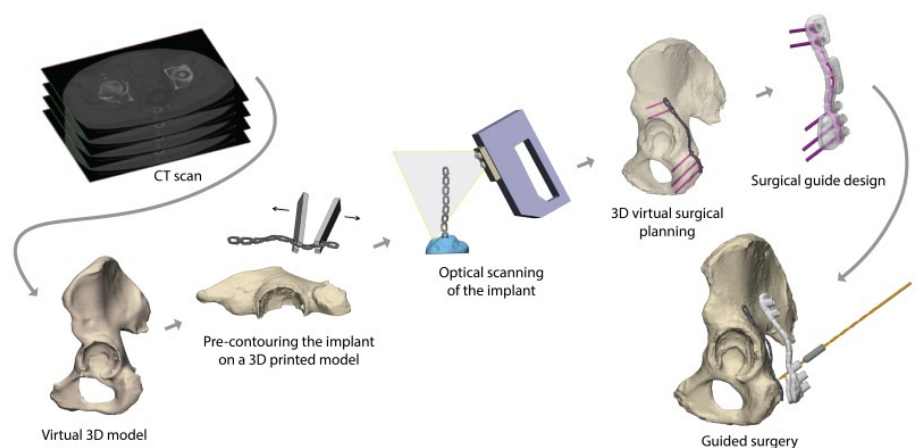
Figure 3. Workflow of the preoperative planning. A 3D model is created from the CT scan. The implant was pre-contoured on a 3D printed model and optically scanned. The implant was matched with the 3D model, and the screw directions and positions were predetermined. The personalized surgical drilling guide was designed and 3D printed for intraoperative use.